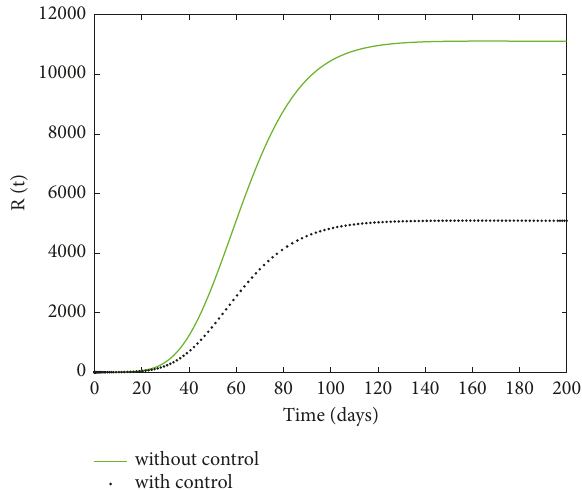
Figure 16: Behaviour of the individuals removed from COVID-19 with and without lockdown control.